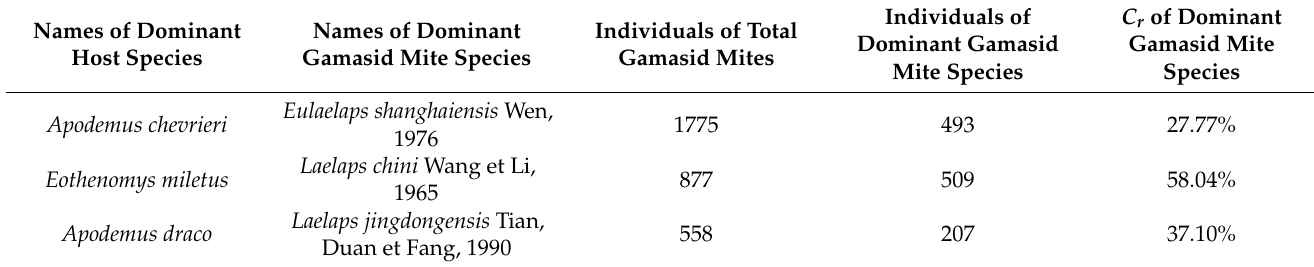
Table 4. Dominant species of gamasid mites on three dominant species of small mammals in Three Parallel Rivers Area in northwest Yunnan of China